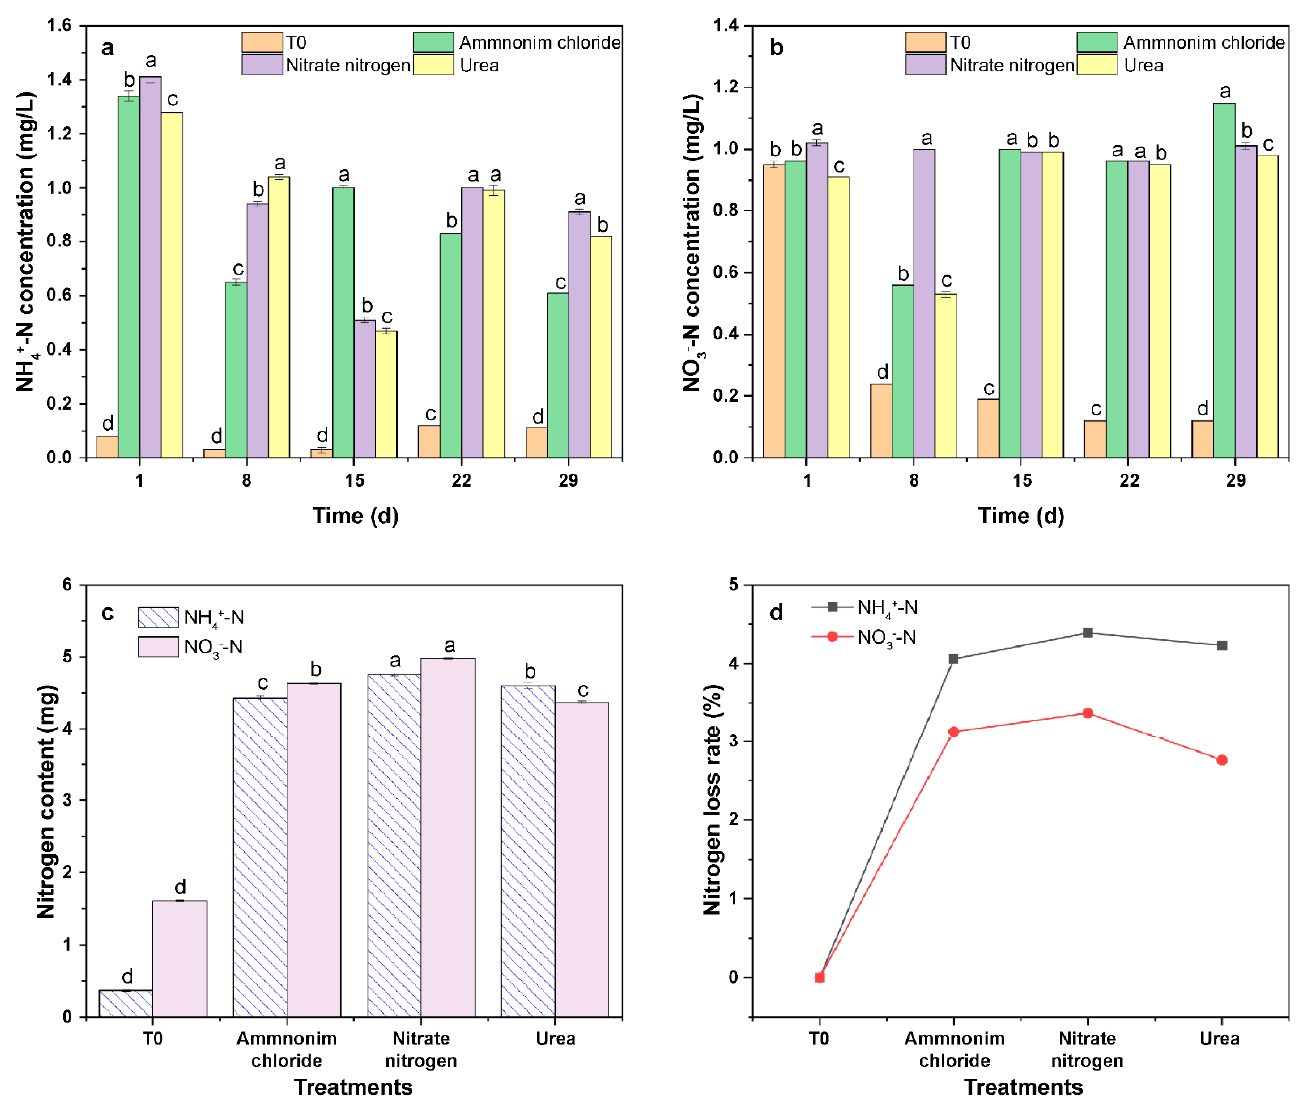
Figure 7. Variations in the ( a , b ) NH 4+ -N and NO 3 − -N concentrations, ( c ) cumulative leaching losses, and ( d ) leaching rates under the treatments. T0 treatment: Latosol without addition of fertilizer in the column; Ammonium chloride, Nitrate nitrogen, and Urea treatments: Latosol containing addition of fertilizer in the column; the N application levels of the urea, ammonium chloride, and ammonium nitrate treatments were similar at 200 mg/kg; the cumulative leaching losses of NH 4+ -N and NO 3 − -N under the fertilizer-free treatment were 0.37 and 1.61 mg, respectively; the different letters in the same column indicate that the differences were statistically significant at the p < 0.05 level nitrogen.